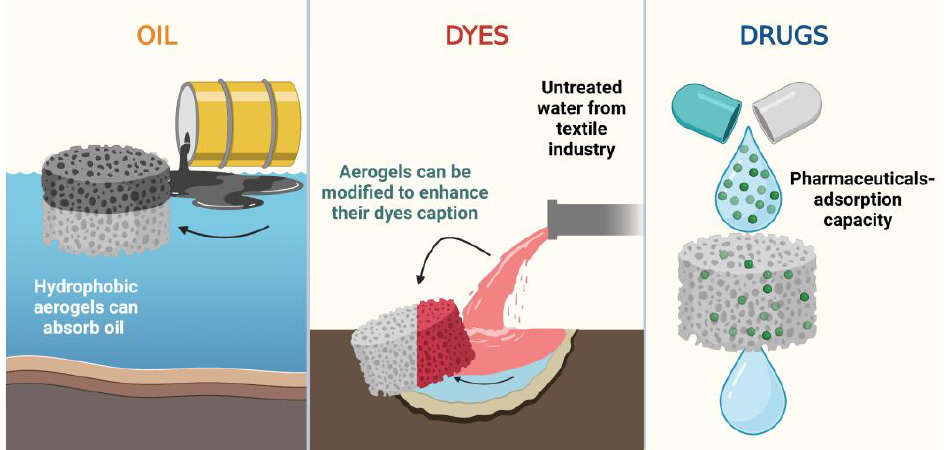
Figure 2. Due to their characteristics, biopolymeric aerogels serve as a removal alternative for oils, dyes, and pharmaceuticals.